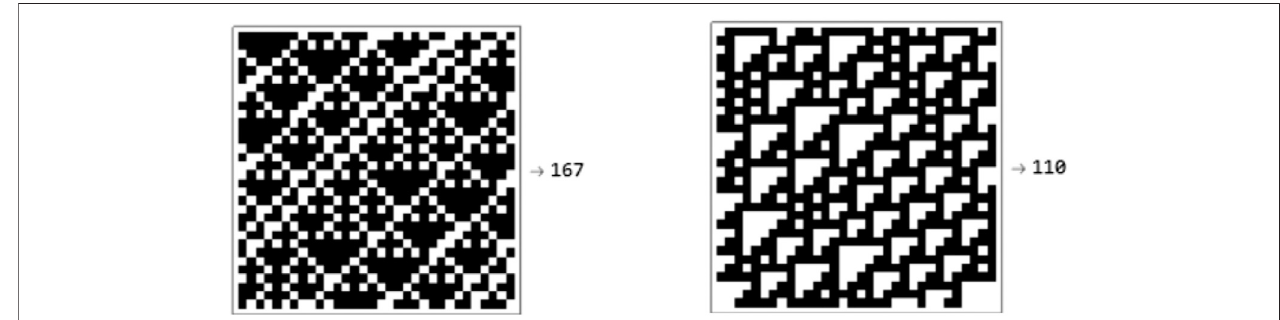
FIGURE 2 | Two 32 × 32 images and their respective classes. The images represent the evolution of the automata 167 and 110 for two different randomly generated 32-bits binary